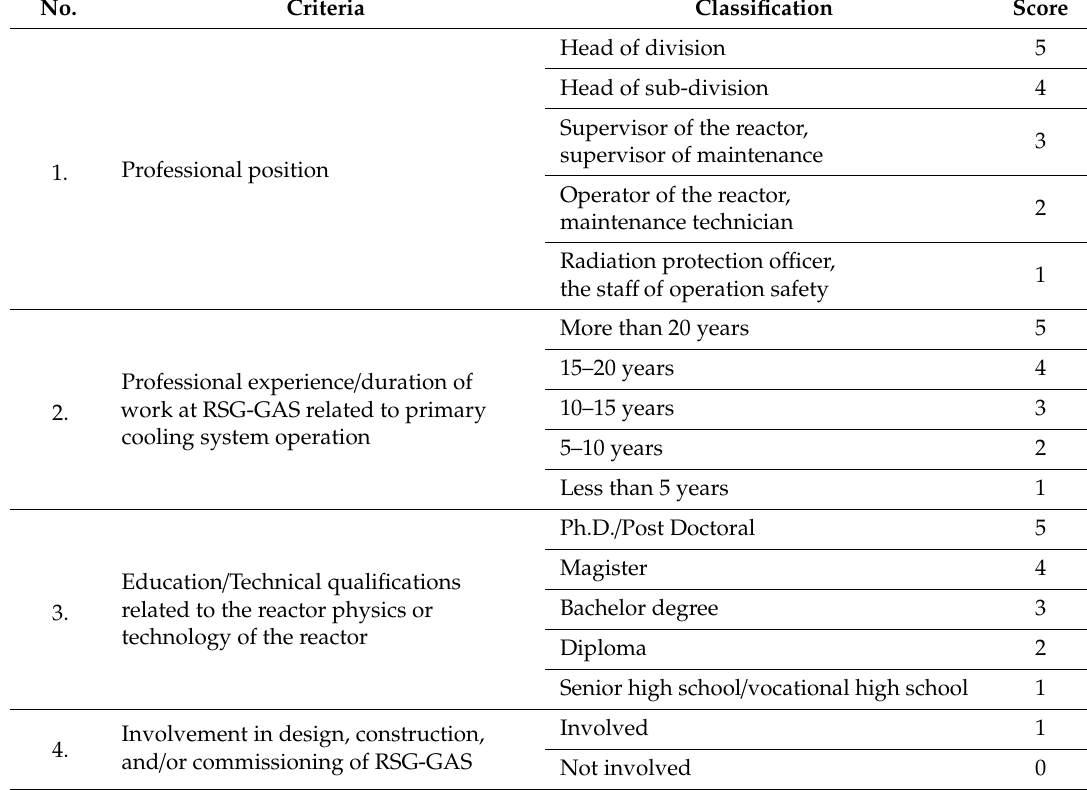
Table 1. Experts weighting [34]. RSG-GAS: G.A. Siwabessy Multipurpose Reactor.